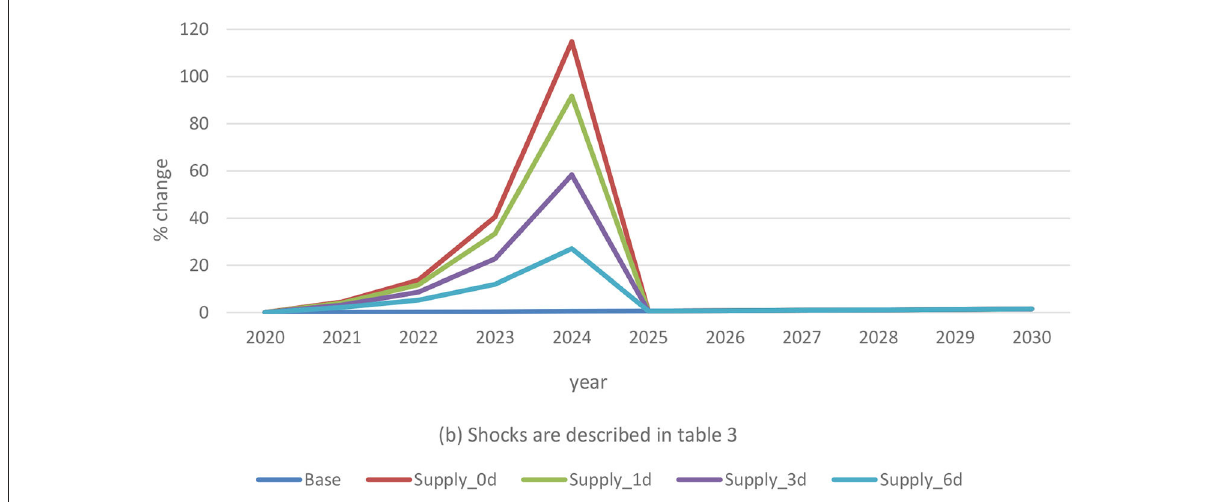
FIGURE4 Traditional pig price changes in combined scenarios. (b) Shocks are described in Table 3.